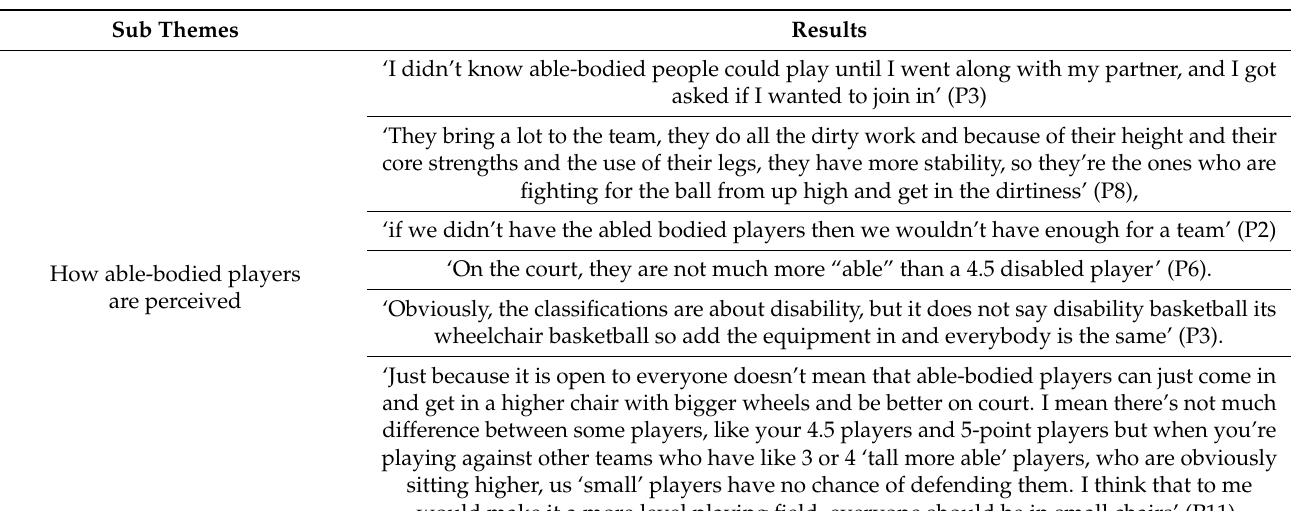
Table 2. Players’ perceptions of able-bodied involvement in wheelchair